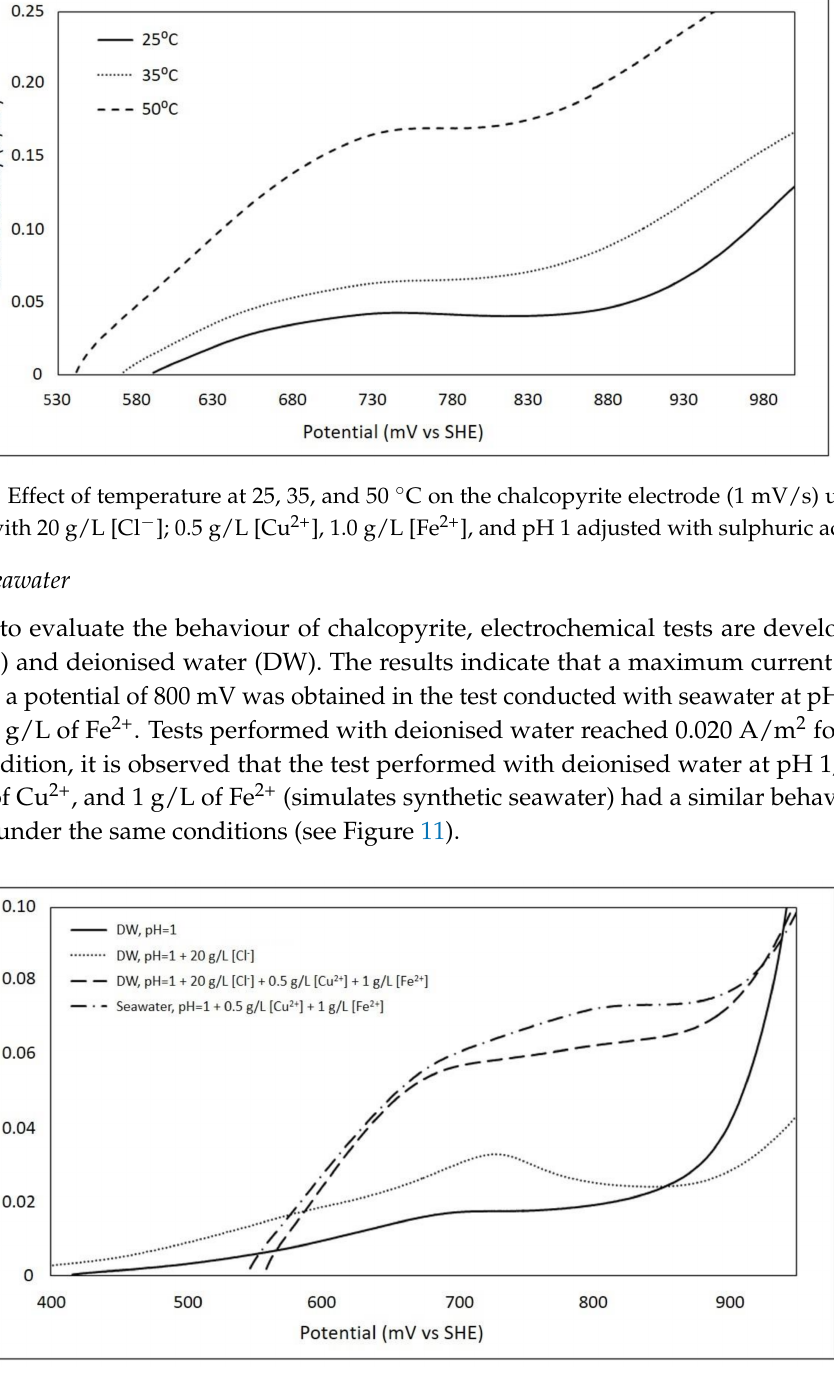
Figure 11. Effect of seawater on the chalcopyrite electrode (1 mV/s) using four different solutions at pH 1 adjusted with H 2 SO 4 ; deionised water (DW) with no addition of any reagent; DW adding 20 g/L [Cl − ]; DW adding 20 g/L [Cl − ], 0.5 g/L [Cu 2+ ], and 1.0 g/L [Fe 2+ ]; and Seawater adding 0.5 g/L [Cu 2+ ] and 1.0 g/L [Fe 2+